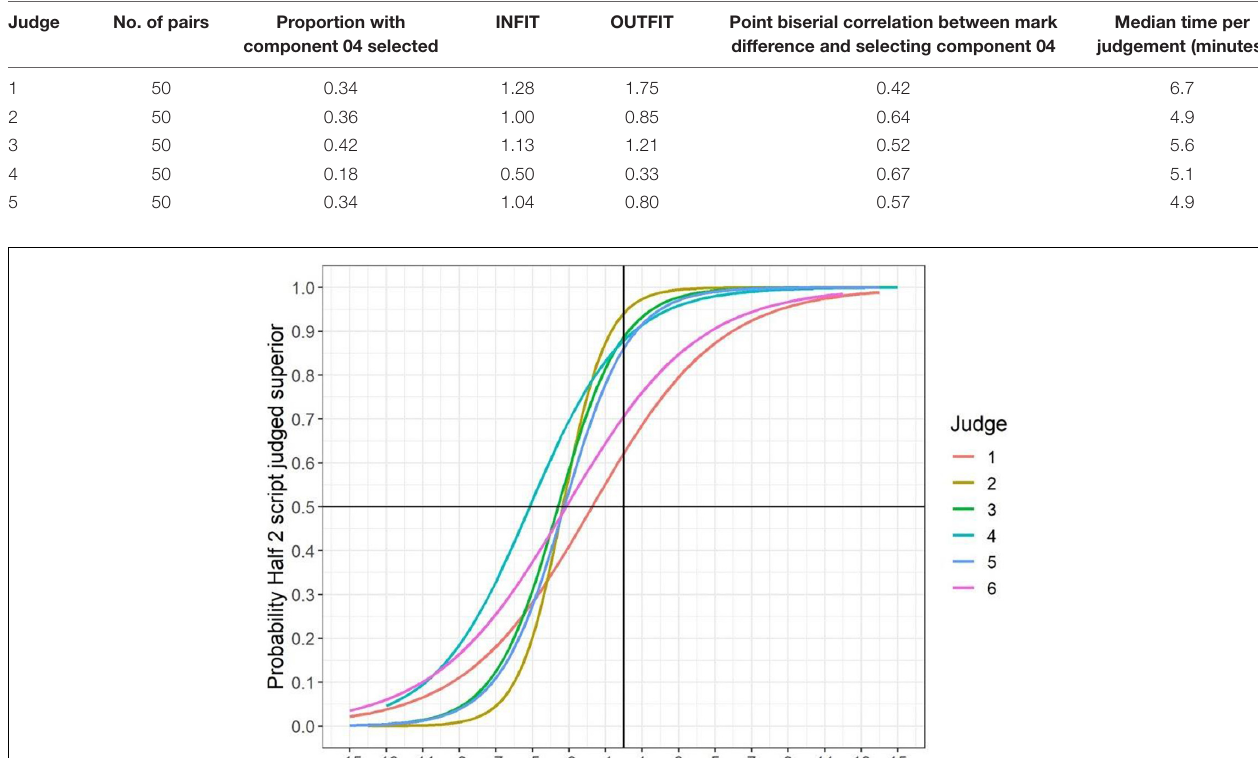
TABLE 6 | Judge fit and speed for each of the five judges (science).